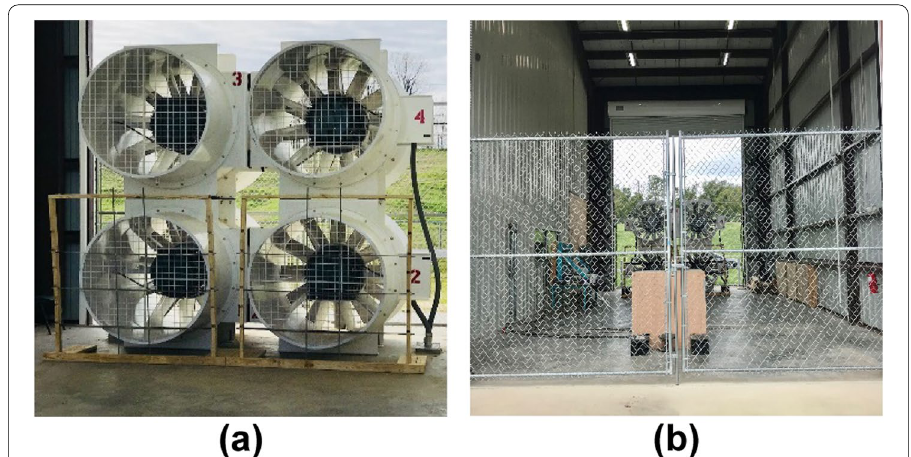
Fig. 6 LSU WISE Open-jet: ( a ) Open-jet with flow management frame, and ( b ) Instrumented